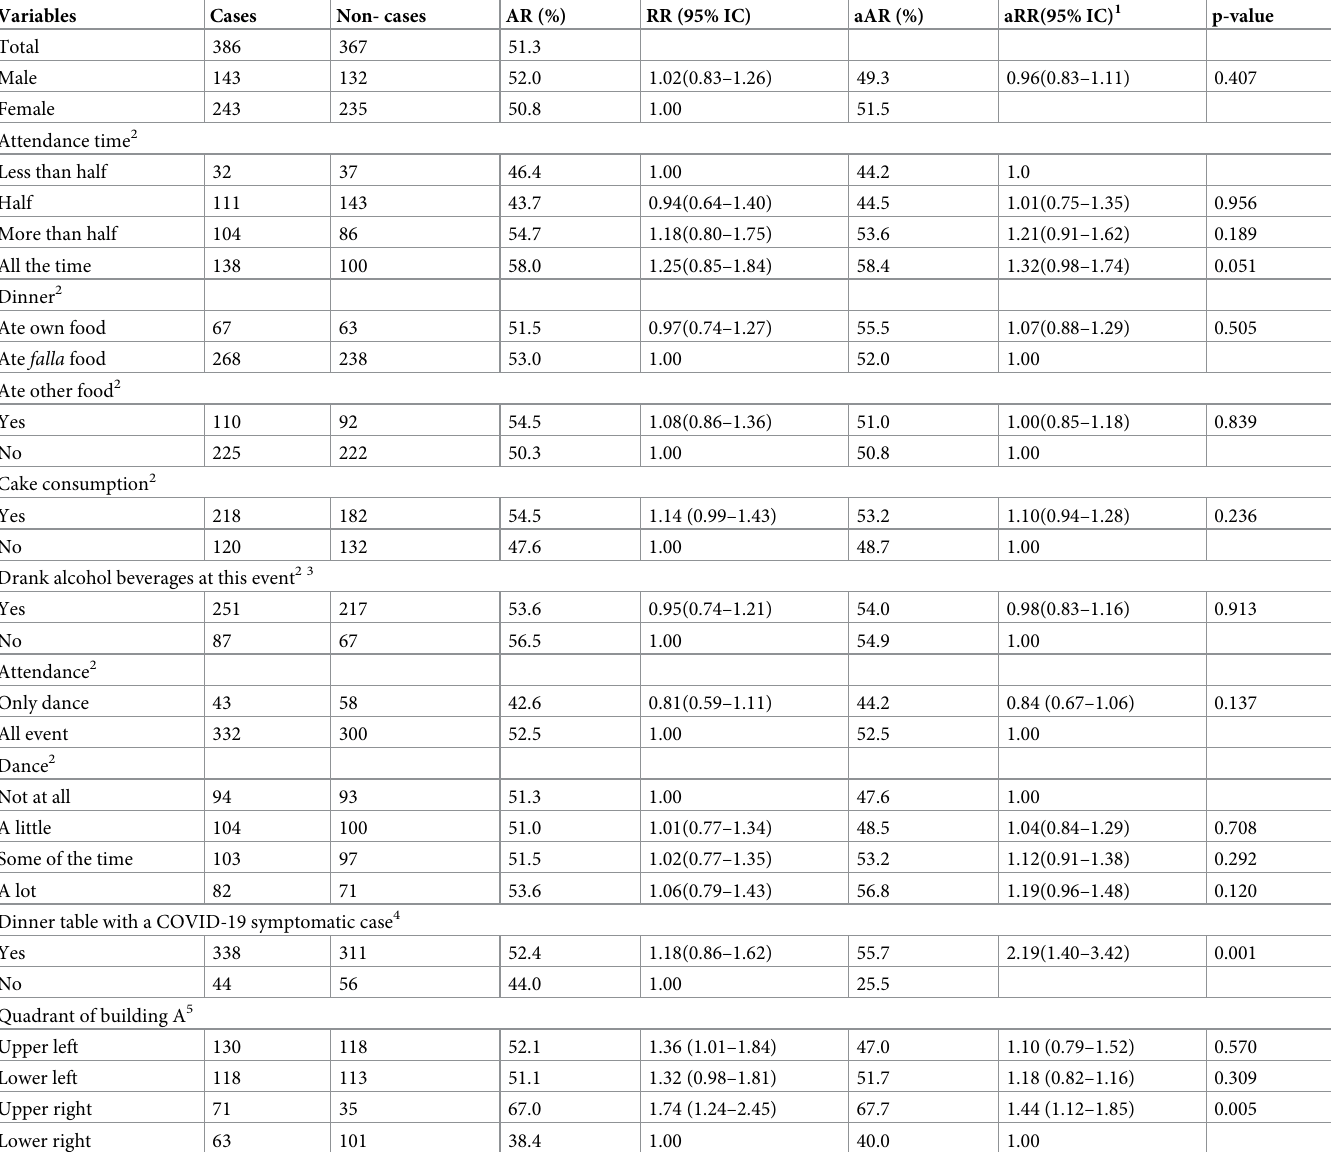
Table 5. Pa-i-porta, Mass Gathering Event (MGE) attendance, Attack Rate (AR), adjusted AR (aAR), Relative Risk (RR), and adjusted (aRR). Confidence interval (CI). From March 6 to 31, 2020,